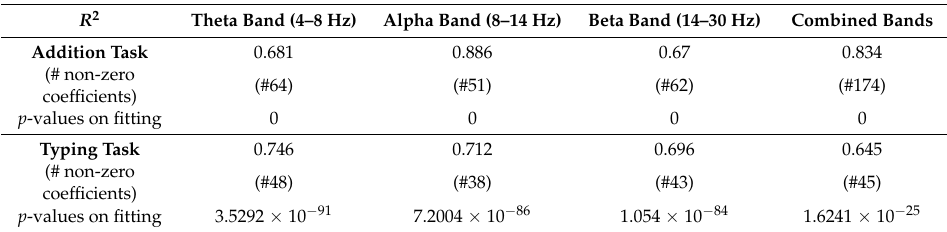
Table 5. R 2 obtained between observed and estimated performance for office tasks using LASSO regression and the number of non-zero coefficients in the fitted LASSO model.